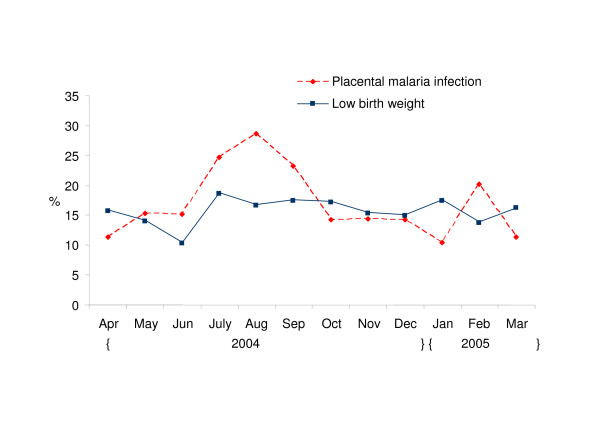
Monthly variation of low birth weight and placental malaria prevalence in singleton live births. Ouidah, Kindji and Hopital de Zone maternity clinics, April 2004-April 2005, N = 1090.